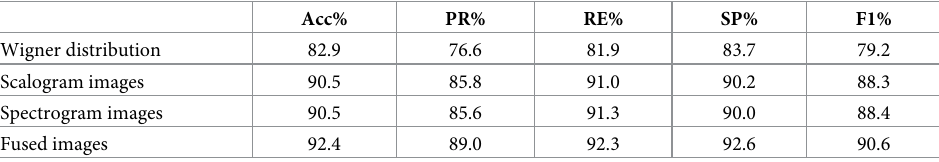
Table 1. Overall performance in per-segment apnea detection TFR images and fused